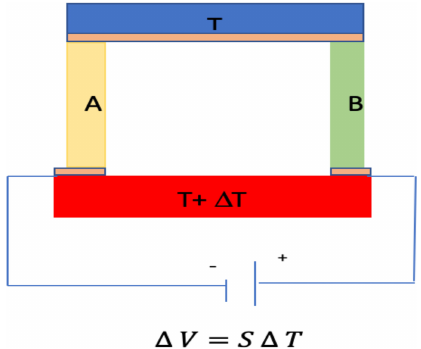
Figure 1: Simple diagram illustrating the Seebeck effect. Material A and material B are subjected to temperature difference ∆ T, which induced a voltage difference ∆